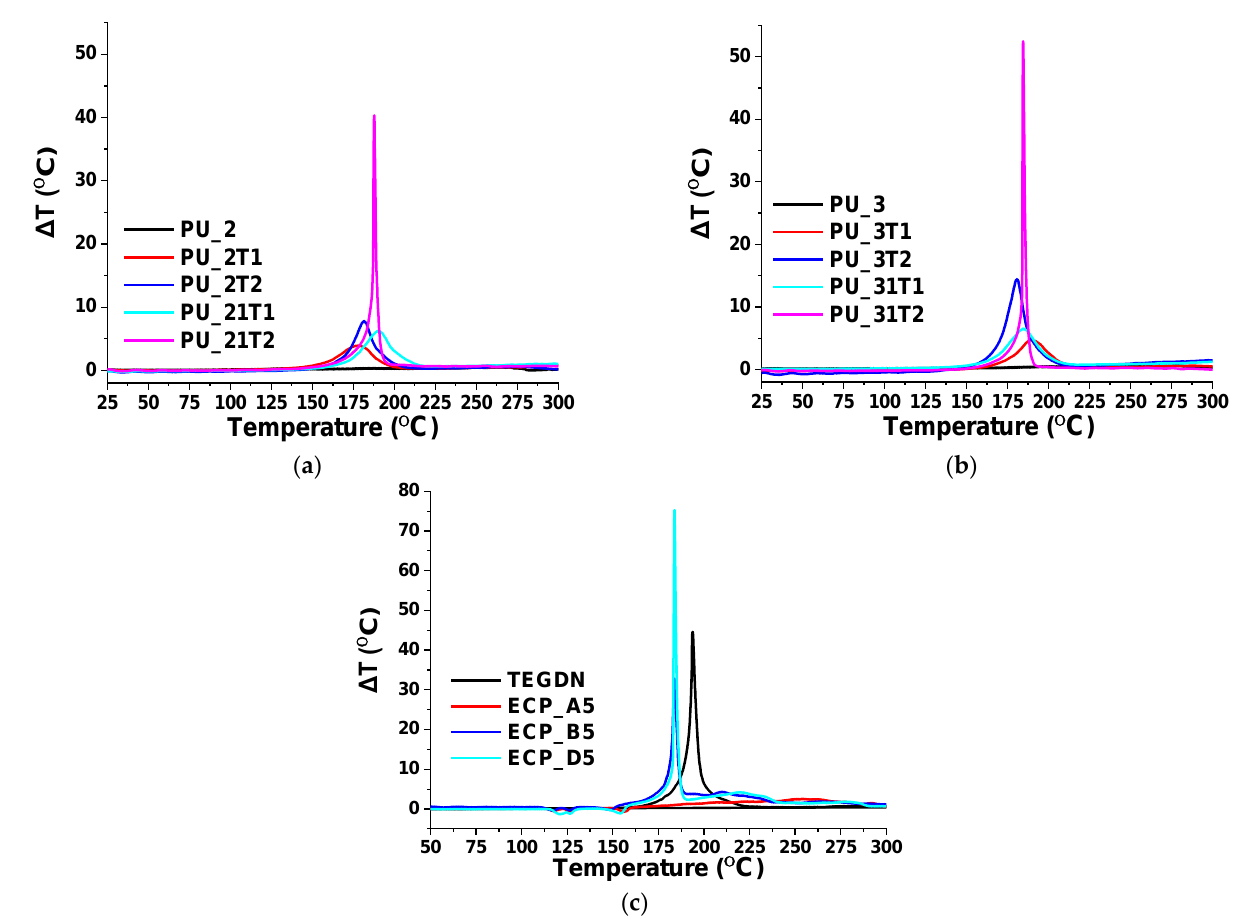
Figure 4. DTA thermograms for polyurethane films: ( a ) 3:2 -NCO/-OH group molar ratio; ( b ) 2:1 -NCO/-OH group molar ratio; ( c ) neat TEGDN and composite rocket propellants.